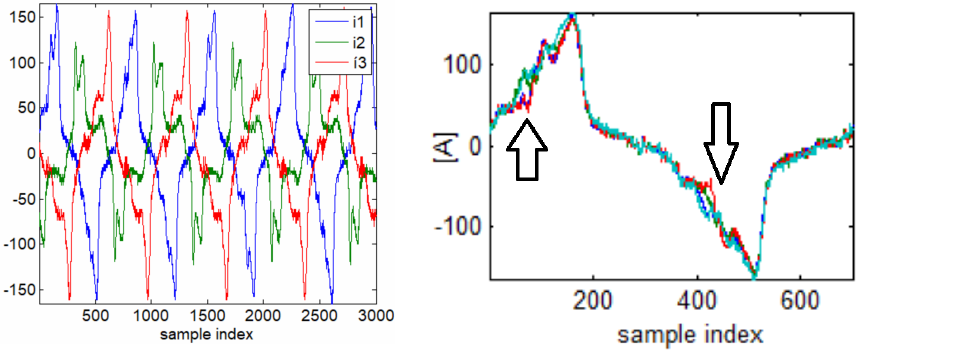
Figure 2. 4 overlapped periods from one of the ana- lyzed